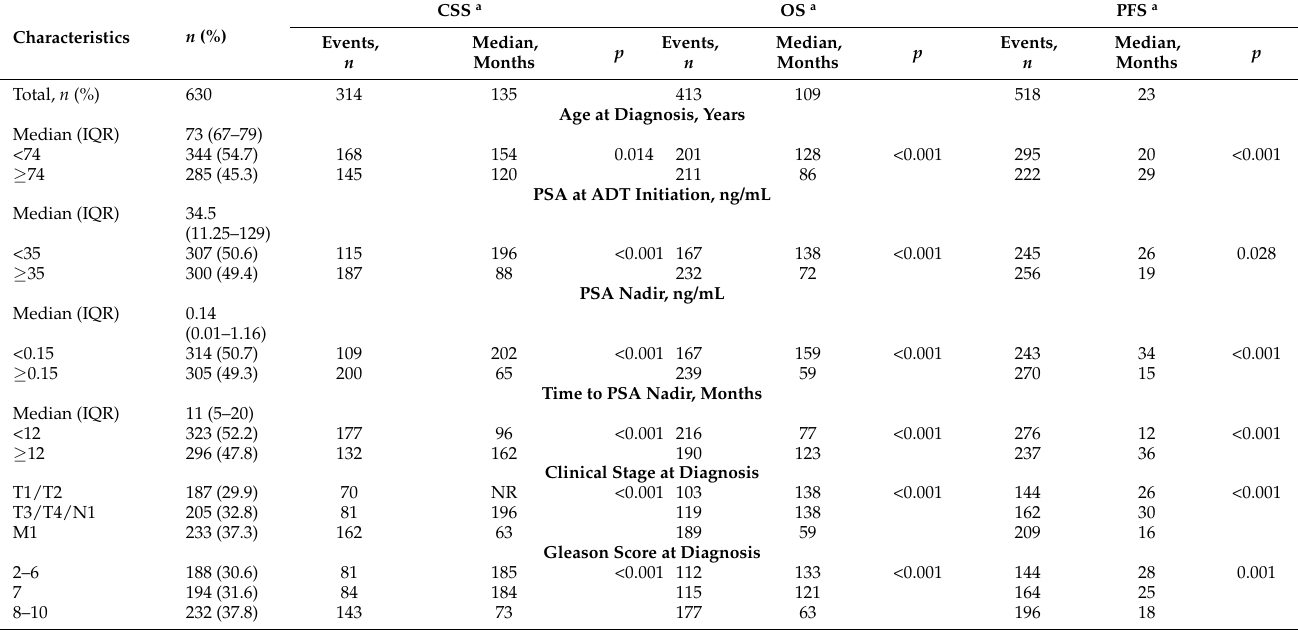
Table 1. Clinicopathologic characteristics of the study population.